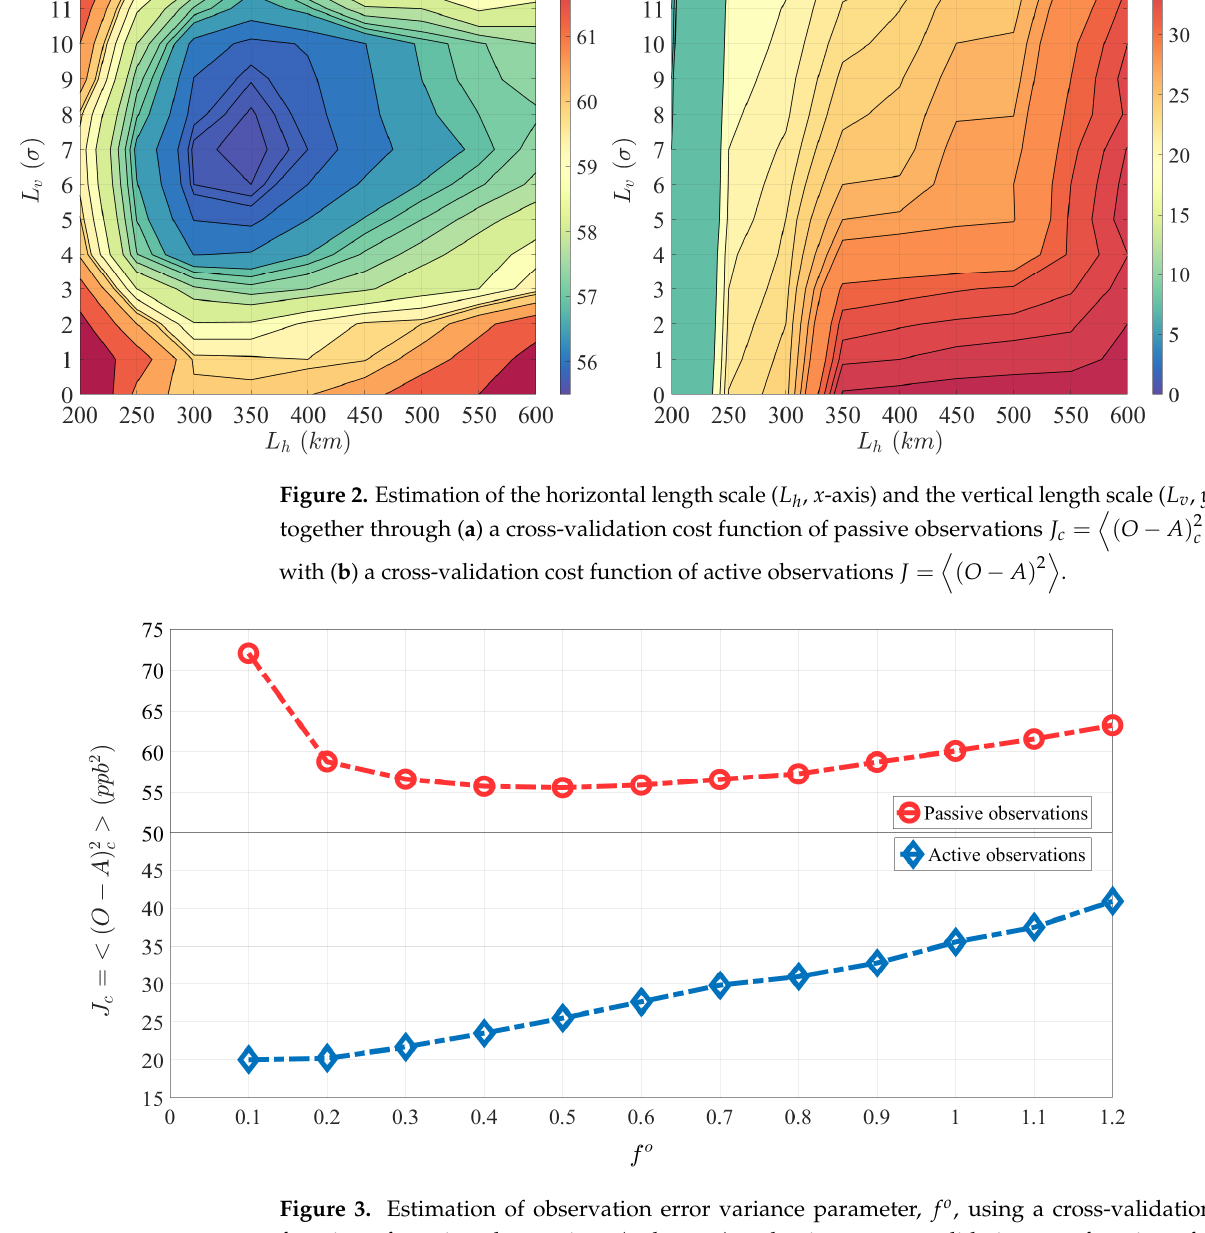
Figure 3. Estimation of observation error variance parameter, o f , using a cross-validation cost function of passive observations (red curve) and using a cross-validation cost function of active ob- servations (blue curve).